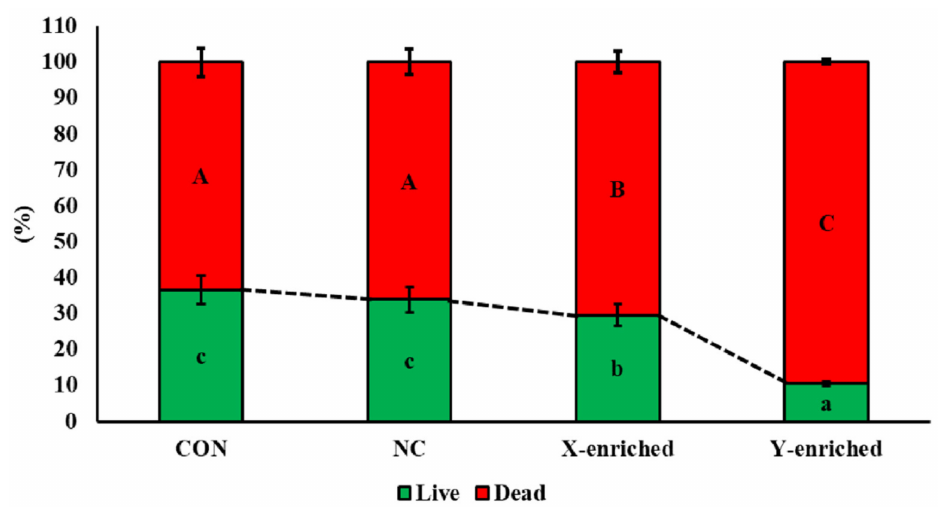
Figure 5. The percent viability of frozen–thawed sexed semen by PY-microbeads. Con: conventional frozen–thawed semen; NC: conventional semen incubated with nonactive PLA-M microbeads; X-enriched: sperm unbound by PY-microbeads; Y-enriched: sperm entrapped by PY-microbeads; A, B, C = comparison of dead sperm in each group; a, b, c = comparison of live sperm in each group.